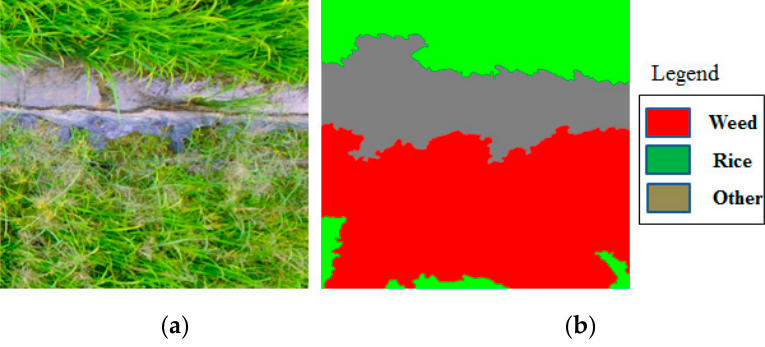
Figure 7. Example of image labeling: ( a ) Input images, and ( b ) labels.